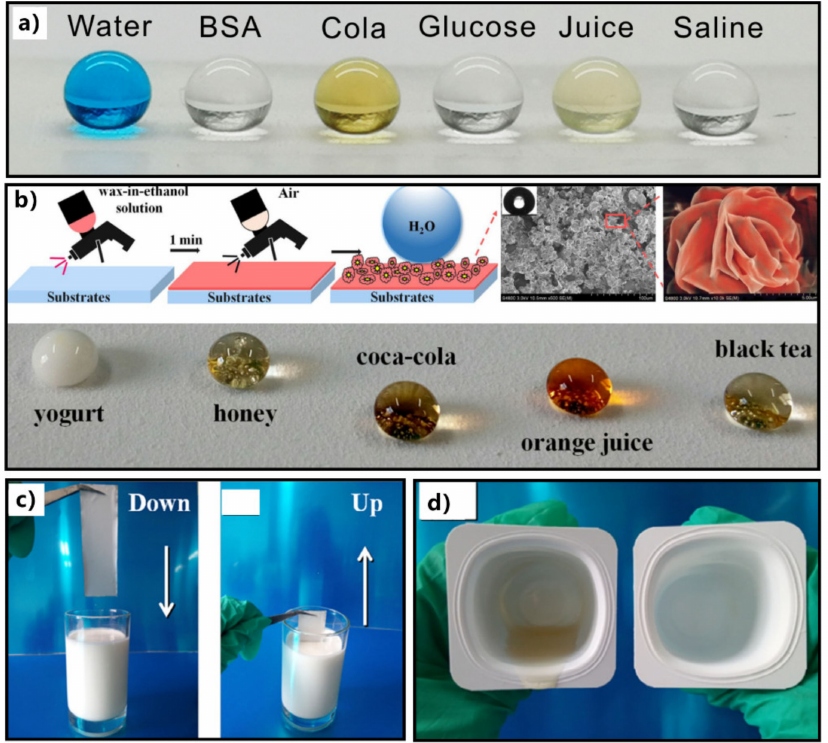
Figure 9. Liquid repellence of the artificial superwetting surfaces. ( a ) Repellence of the hierarchical porous PTFE surface to various liquids. ( b ) Fabrication of superhydrophobic coating resistant to a variety of liquids. ( c ) The superhydrophobic coating thrusting into the yogurt followed by an upward thrust motion. ( d ) After tipping viscous food honey out of (left) an uncoated cup and (right) a superhydrophobic cup. Reprinted from ref. [202]. Reprinted with permission from ref. [203]. Copyright 2019,